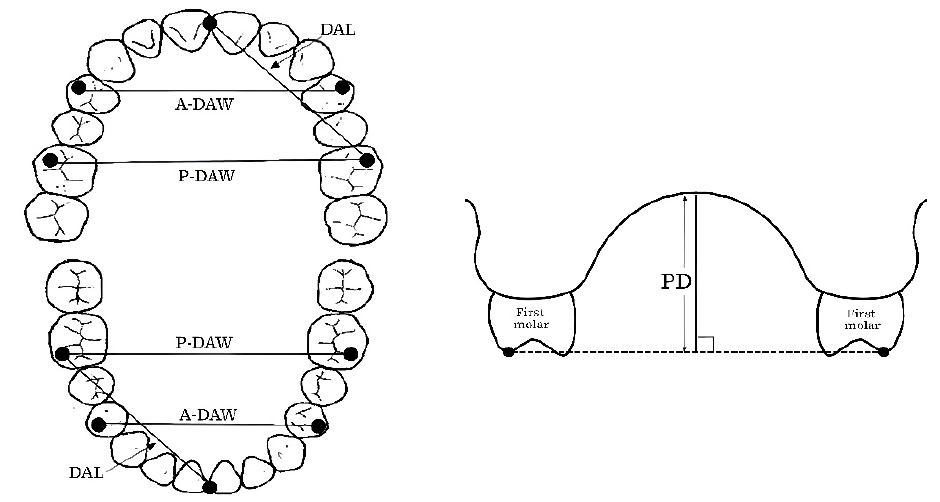
Figure 3. Measurement parameters of the maxillary and mandible on plaster casts.